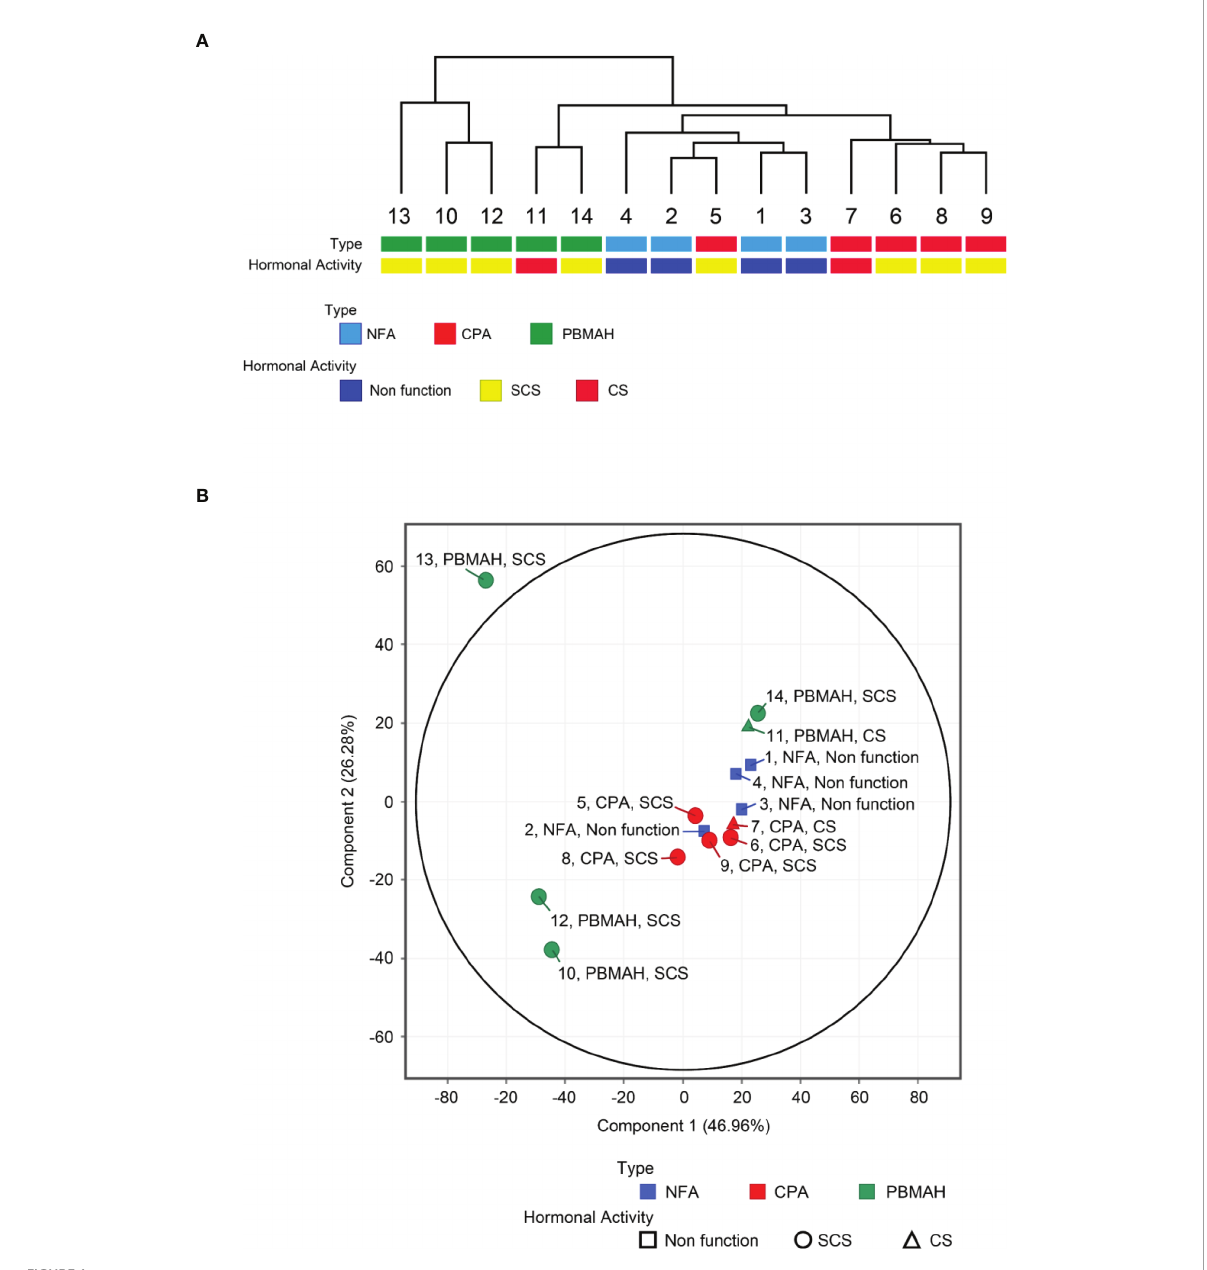
FIGURE 1 Circulating miRNA expression signatures of NFA, CPA and PBMAH. Unsupervised hierarchical clustering analysis (A) and principal component analysis (B) of circulating miRNA pro fi les of NFA (n = 4), CPA (n = 5), and PBMAH (n = 5), with respect to tumor type and hormonal